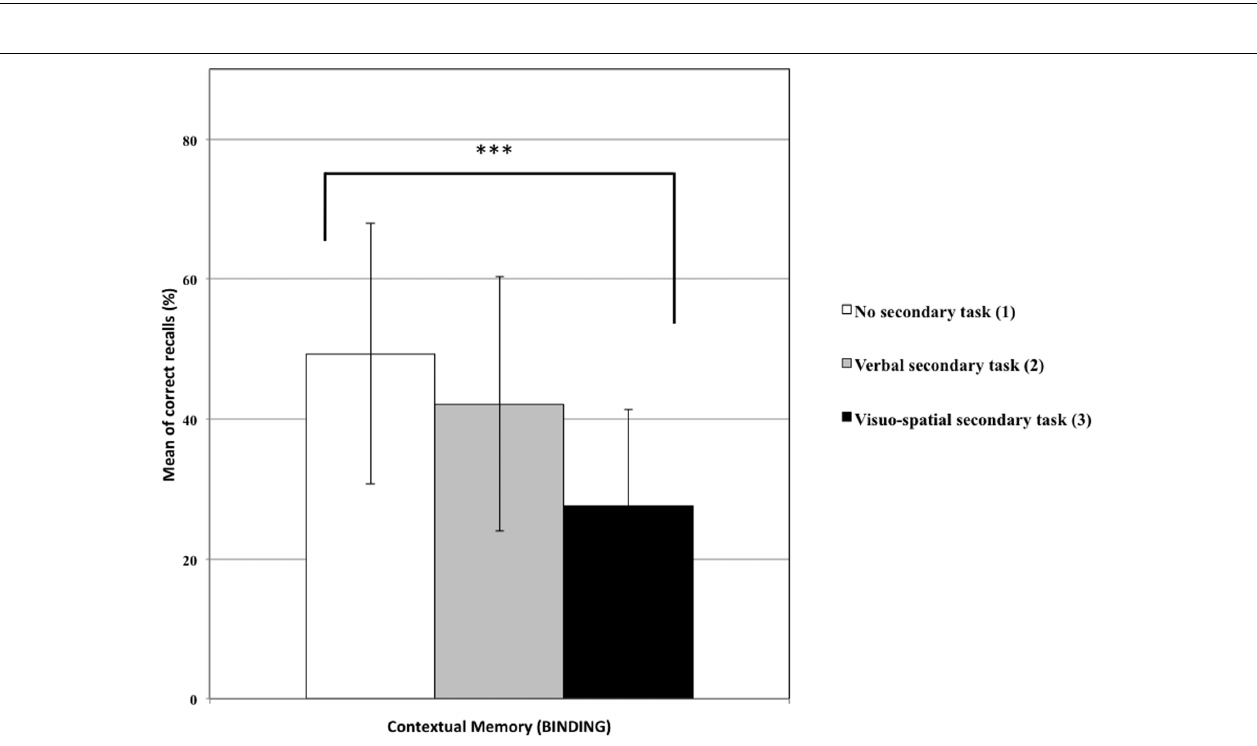
FIGURE 3 | Percentage of central memory for the three experimental conditions (with standard deviation). Conditions 2 and 3 led to less recall than condition 1 (1 versus 2, ∗ p < 0.05; 1 versus 3, ∗∗∗ p < 0.001).